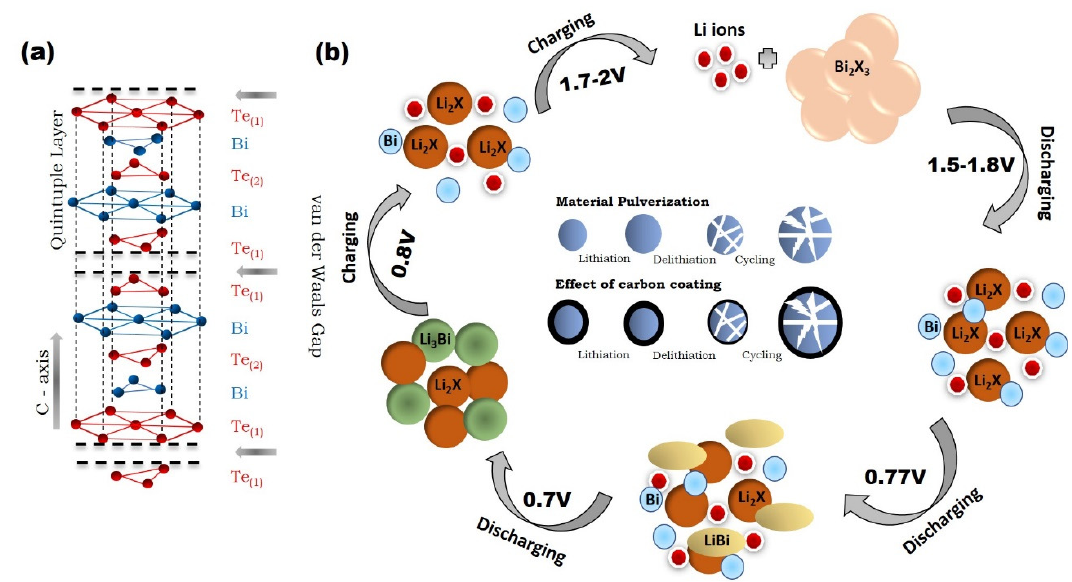
Figure 4. ( a ) Schematic diagram of the crystal structure of Bi 2 X 3 ; ( b ) Schematic diagram of the reaction mechanism of the reaction of Bi 2 X 3 with lithium.